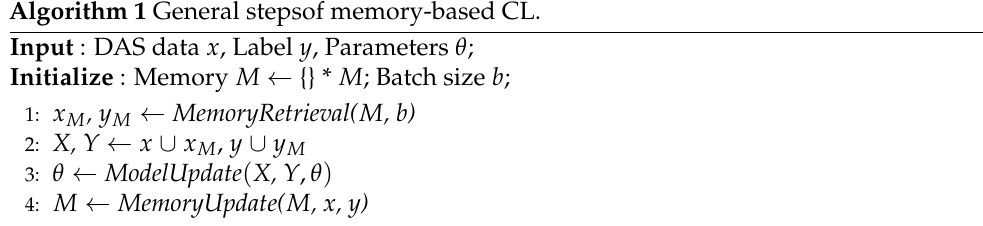
Algorithm 1 General stepsof memory-based